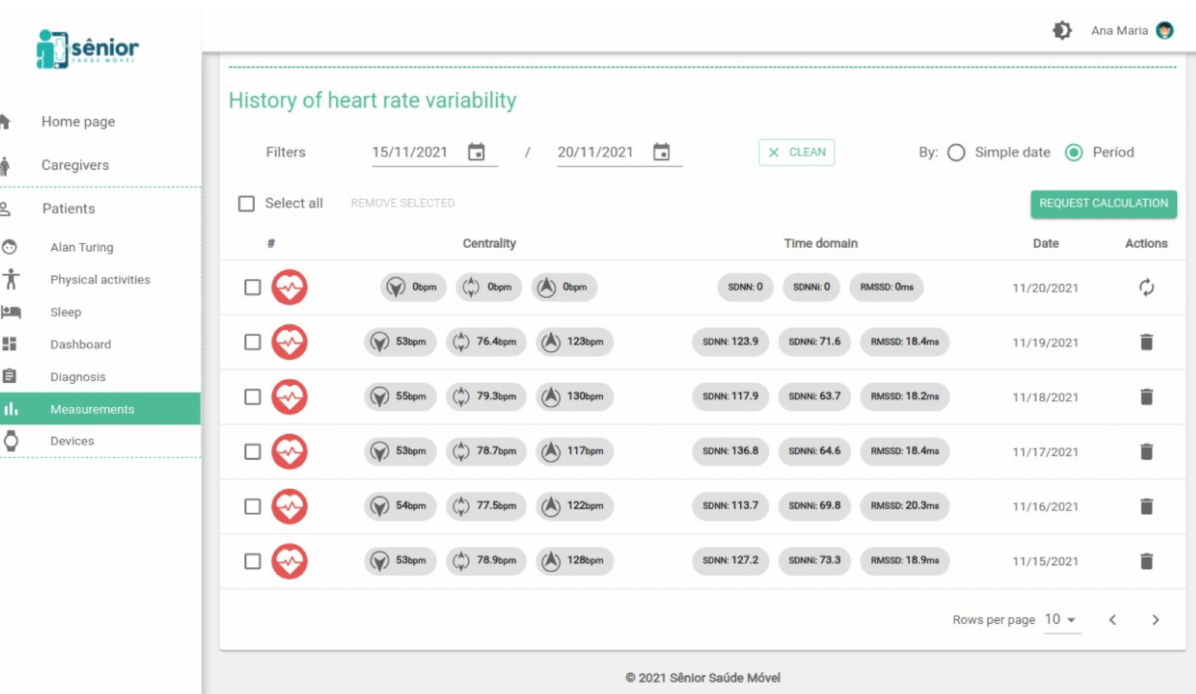
Figure 3. History of heart rate variability screen.